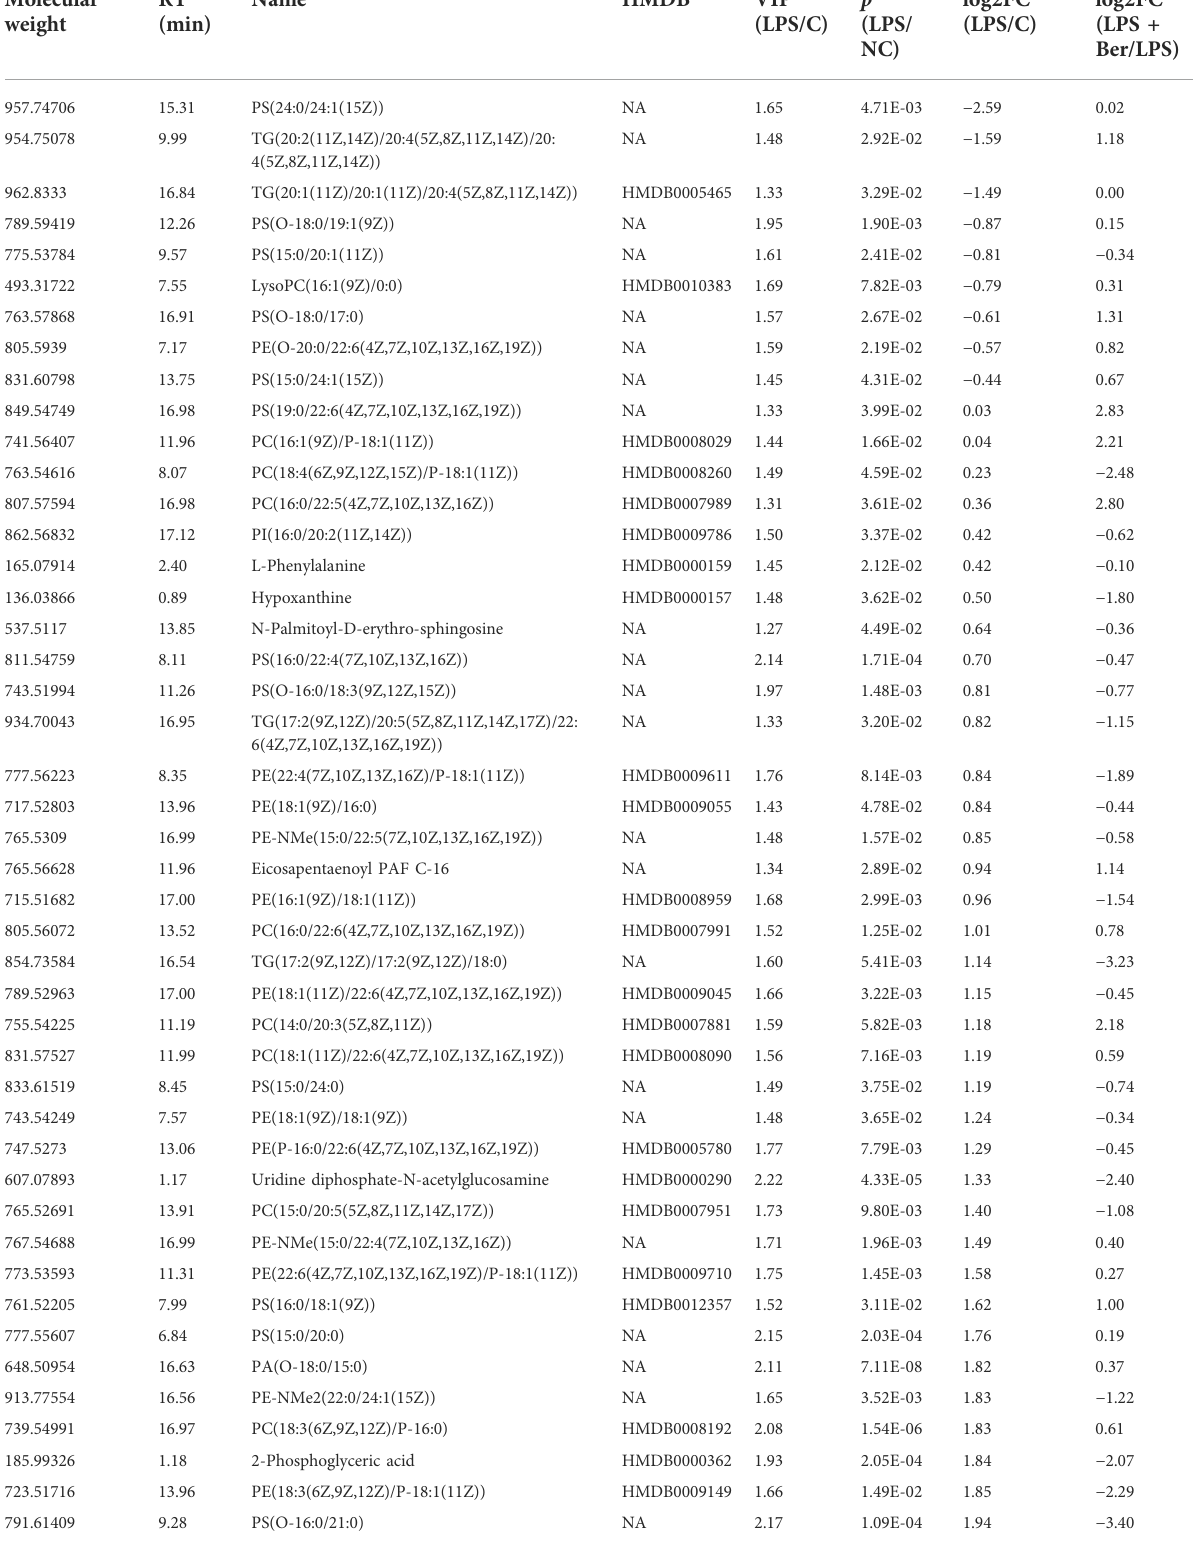
TABLE 1 52 serum metabolites signi fi cantly changed in the comparison of the LPS/NC and LPS + Ber/LPS. Molecular